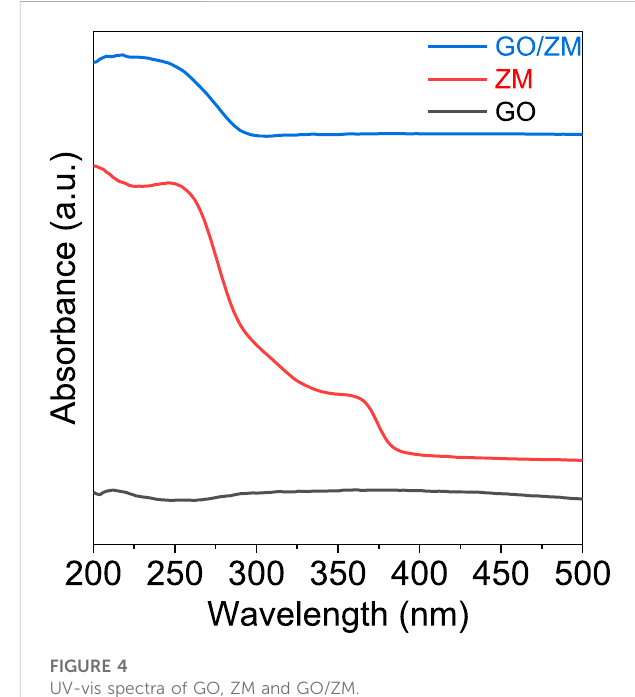
FIGURE 2 FTIR Spectra of GO/ZM nanocomposite.